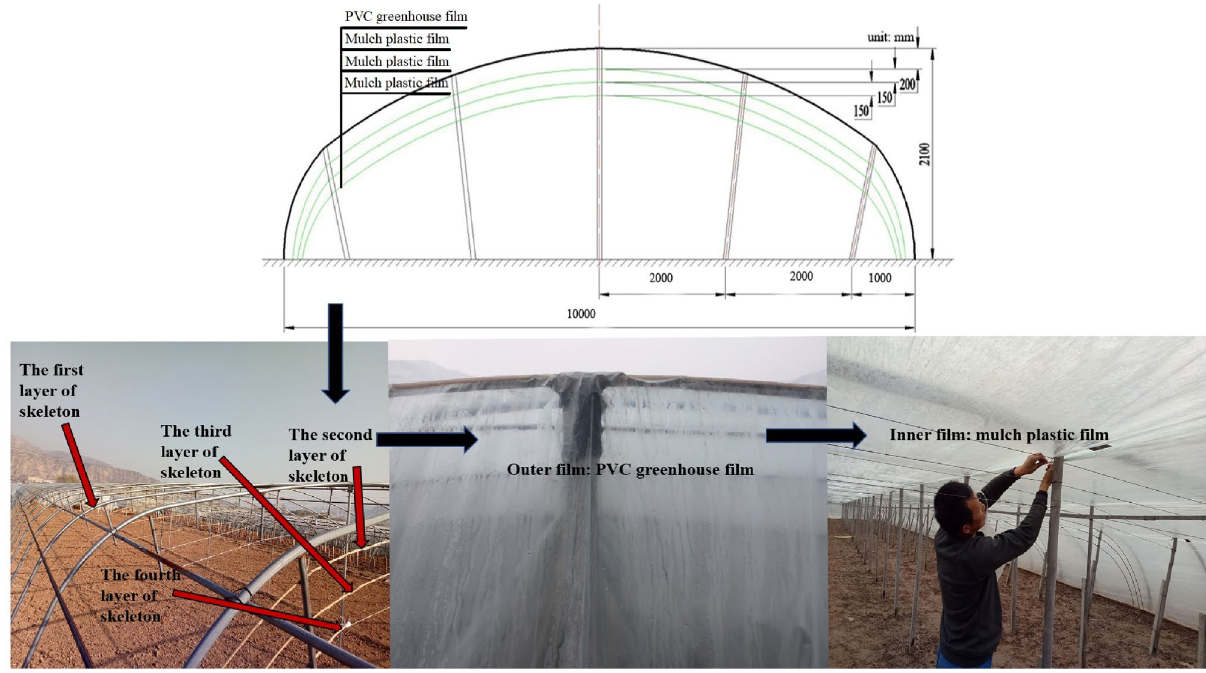
Figure 11. Production mode of the multi-layer (four-layer) covered plastic